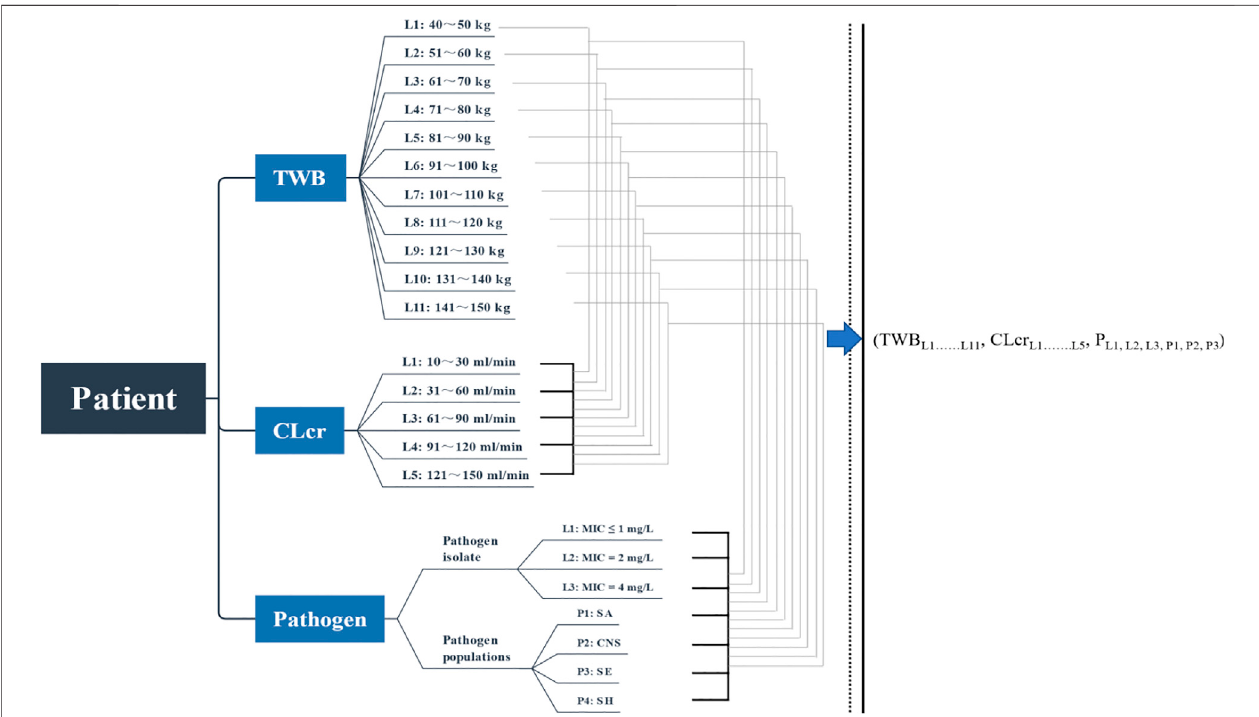
FIGURE 1 | Simulated combination states of TBW – CL cr – MIC. TBW, total body weight; CL cr , creatinine clearance; L, level; P, populations; SA, Staphylococcus aureus ; CNS, coagulase-negative Staphylococcus ; SE, Staphylococcus epidermidis ; SH, Staphylococcus haemolyticus .